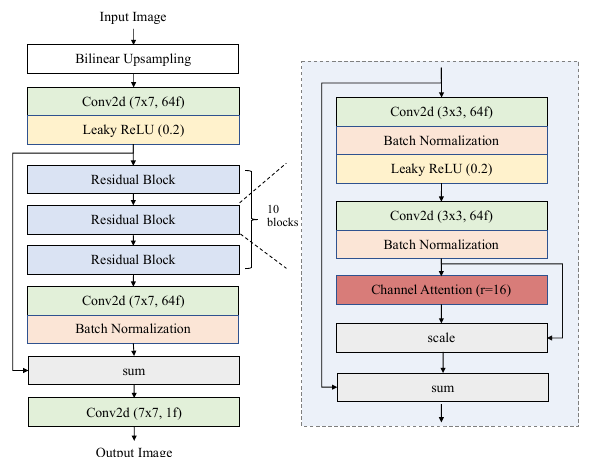
Figure 5 Our Neural Network